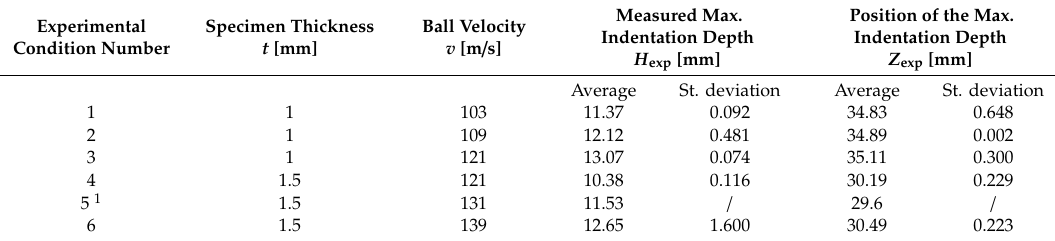
Figure 3. Two views of the experimental specimen. Table 2. Combinations of boundary conditions and the results of the experiment.